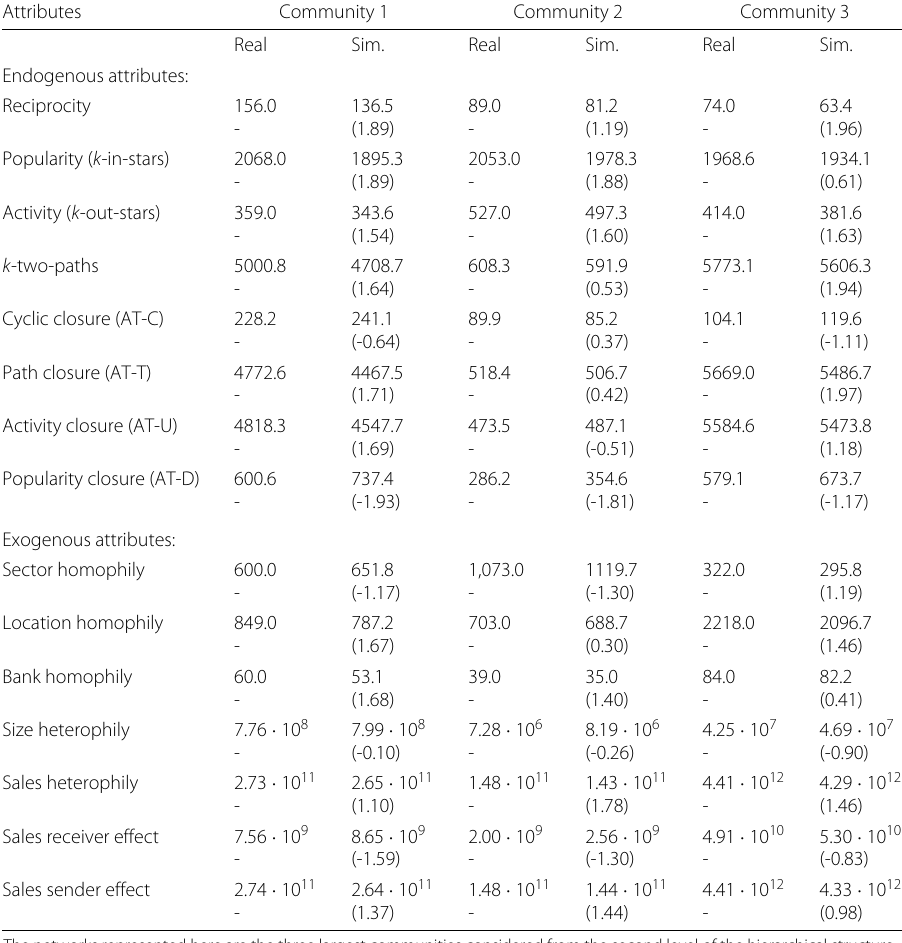
Table 3 GoF analysis: Comparison between real and simulated networks Attributes Community 1 Community 2 Community